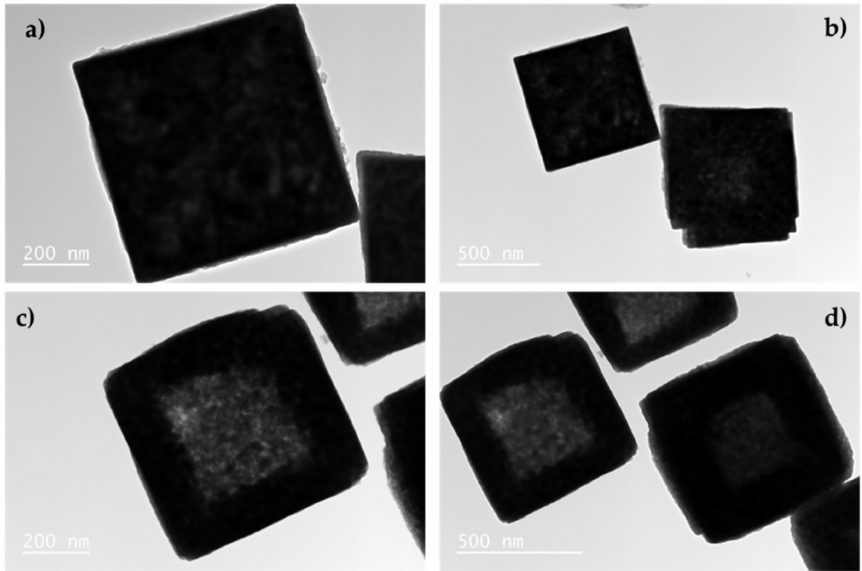
Figure 3. TEM images of ZnSnO 3 at ( a ) 200 nm and ( b ) 500 nm, and Ag-ZnSnO 3 at ( c ) 200 nm and ( d ) 500 nm